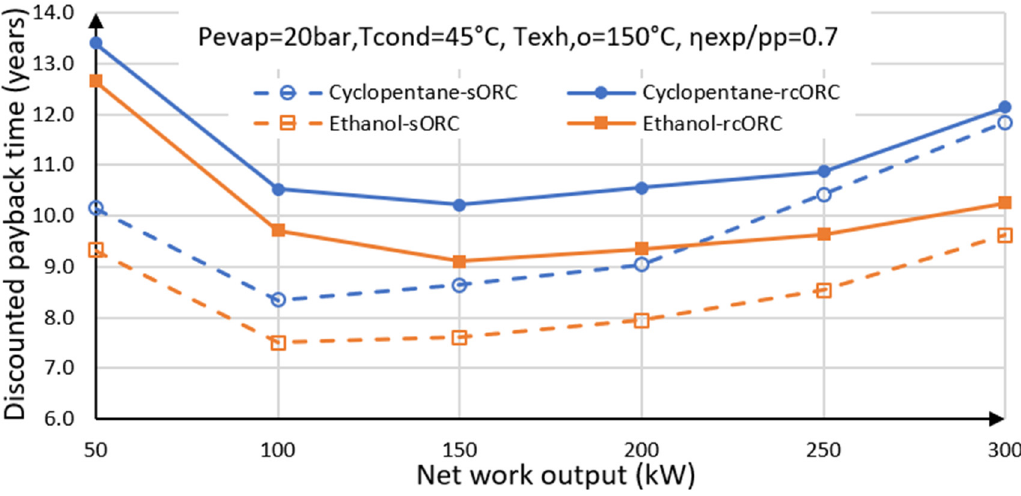
Figure 18. Payback time for ethanol and cyclopentane sORC and rcORCs (with n = 0.25).